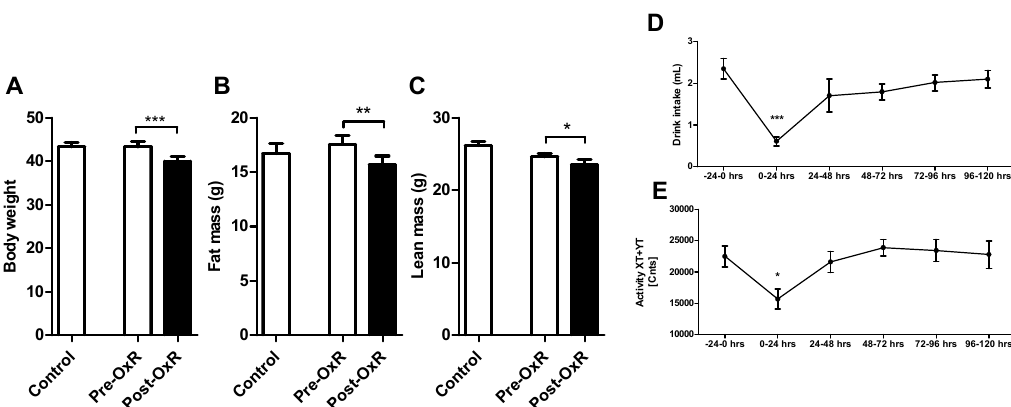
Figure 1. Physiological characteristics of C57BL/6J mice upon oxygen restriction. ( A ) Body weight, ( B ) fat mass, and ( C ) lean mass of control and oxygen restricted (OxR) obese C57BL/6J mice (n = 12/group). Pre-OxR is before intervention with OxR, and Post-OxR indicates after OxR intervention (n = 6/group). ( D ) 24 h drink intake, and ( E ) 24 h activity preceding (–24–0 h) and following 5 days OxR intervention (n = 8–12). Data are shown as mean ± standard error of the mean (SEM); * p < 0.05, ** p < 0.01, *** p < 0.001.